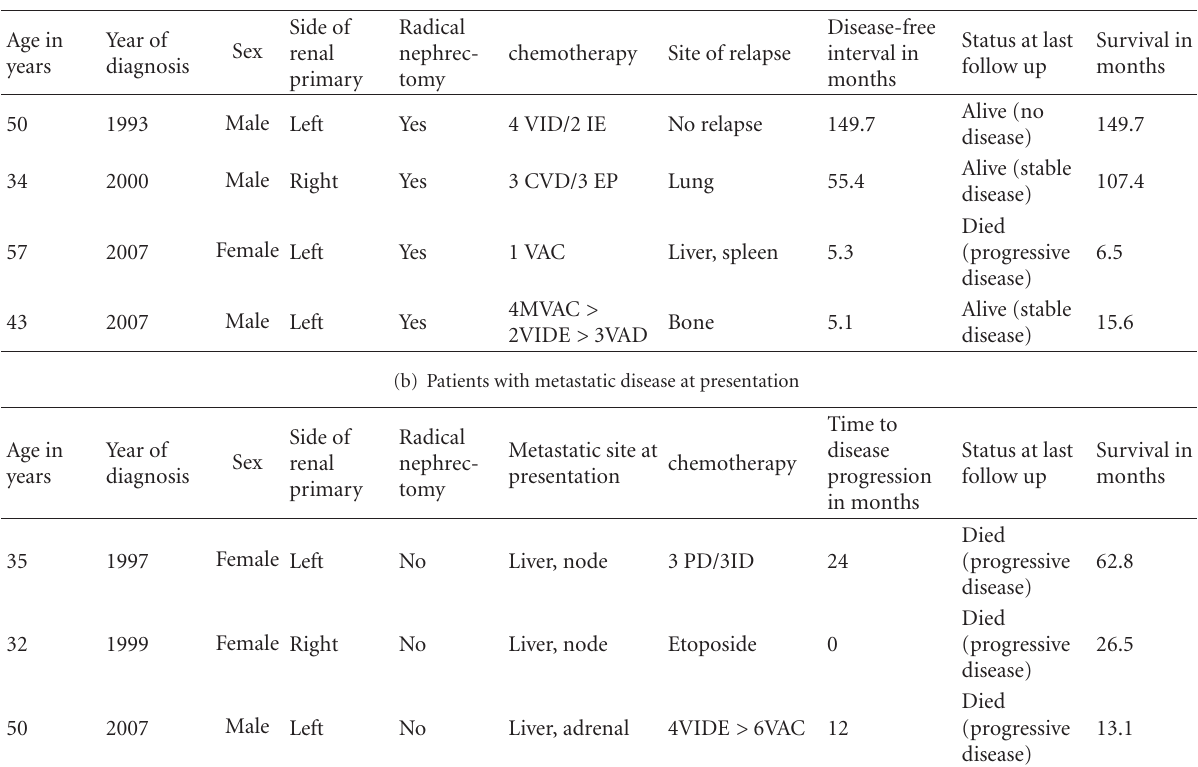
Table 1: Treatment and outcome in the seven patients with primary renal Ewing’s sarcoma.